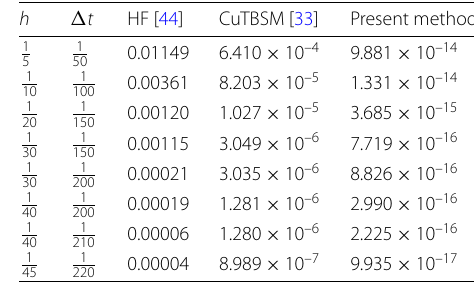
Table 2 Error norm L ∞ at t = 0.2, 0 ≤ z ≤ 1 and α = 1.5 for Example 1